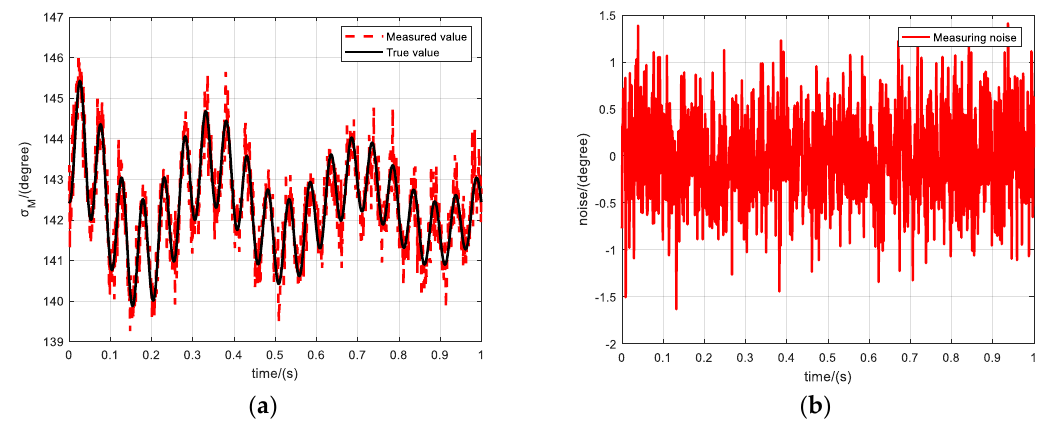
Figure 6. Simulation of magnetic azimuth measurement. ( a ) Magnetic azimuth measurement, ( b ) Measuring noise.